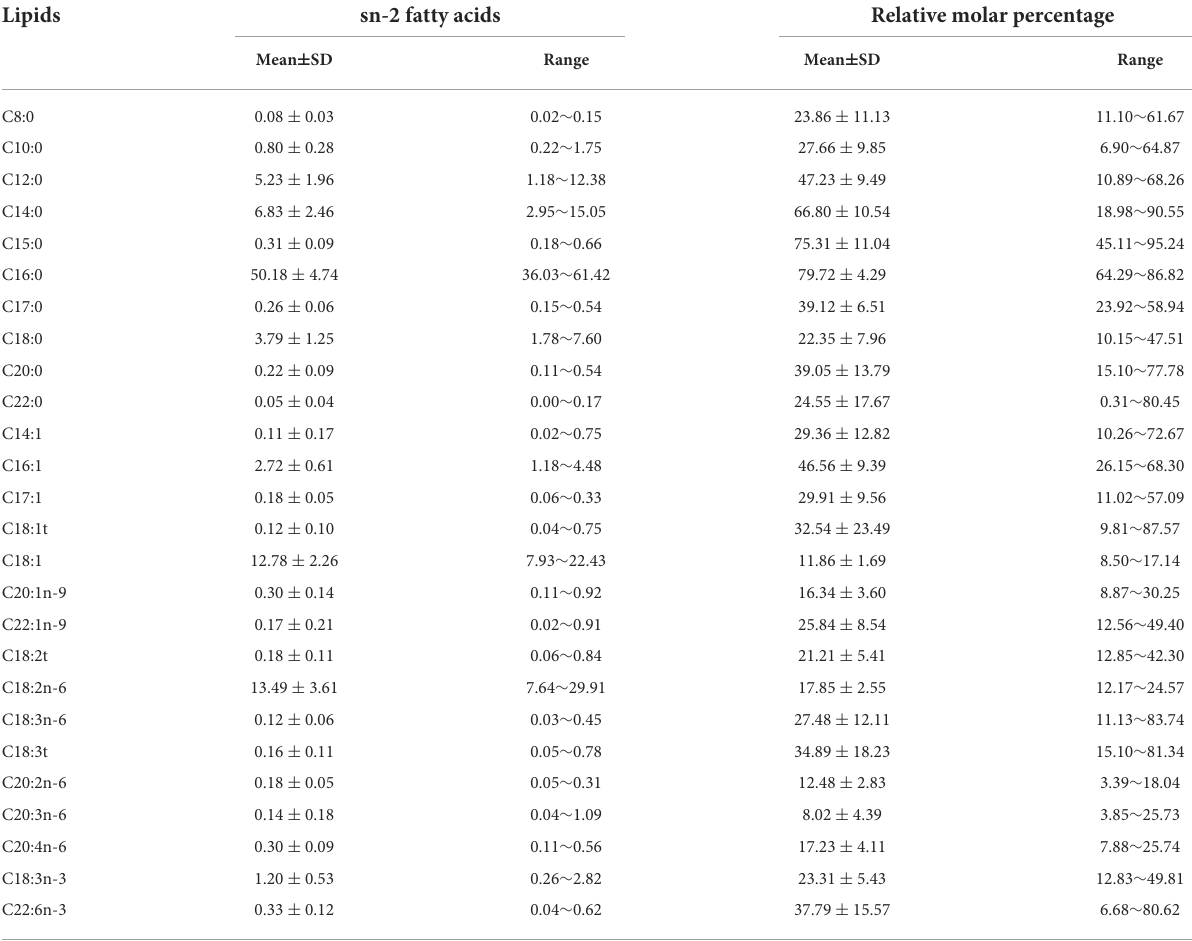
TABLE 3 Composition of sn-2 fatty acids and relative molar percentage a of each fatty acid in mature milk at the sn-2 position (%). Lipids sn-2 fatty acids Relative molar